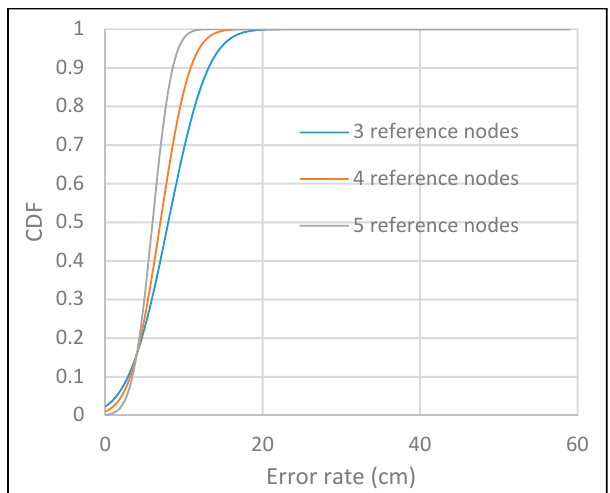
Figure 32. Localization error performance.